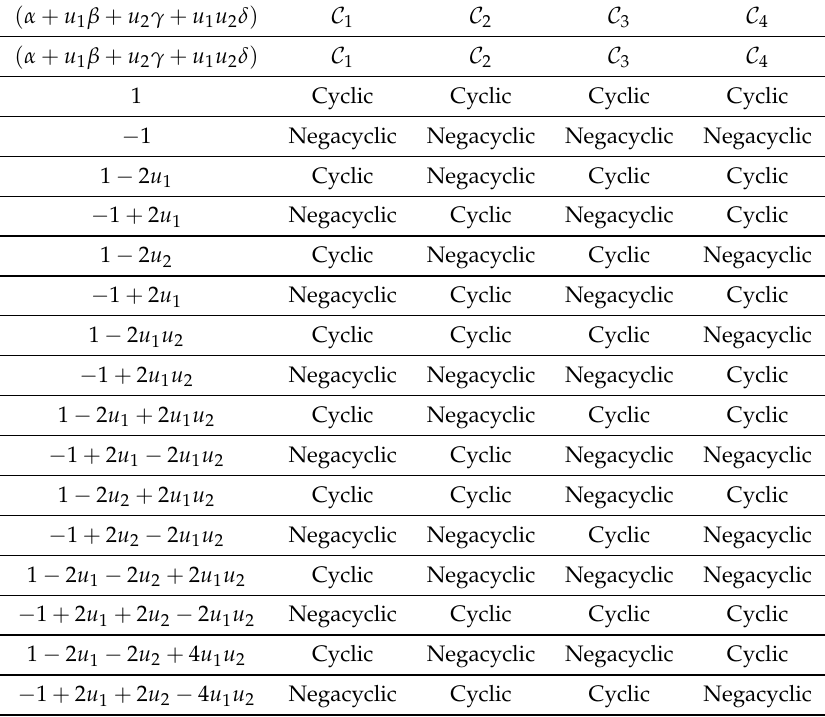
Table 1. Behaviour of C 1 , C 2 , C 3 and C 4 depending on ( α + u 1 β + u 2 γ + u 1 u 2 δ )